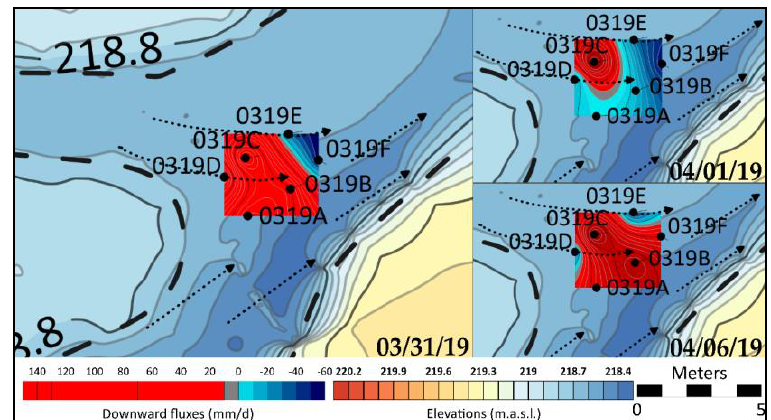
Figure 12. Vertical hyporheic fluxes from FS-BBCB2 (0319). Upper left figure shows HEF pattern on 31 March, upper right figure on 1 April and lower figure on 6 April. Downwelling and upwelling fluxes are represented by red and blue contours, respectively.